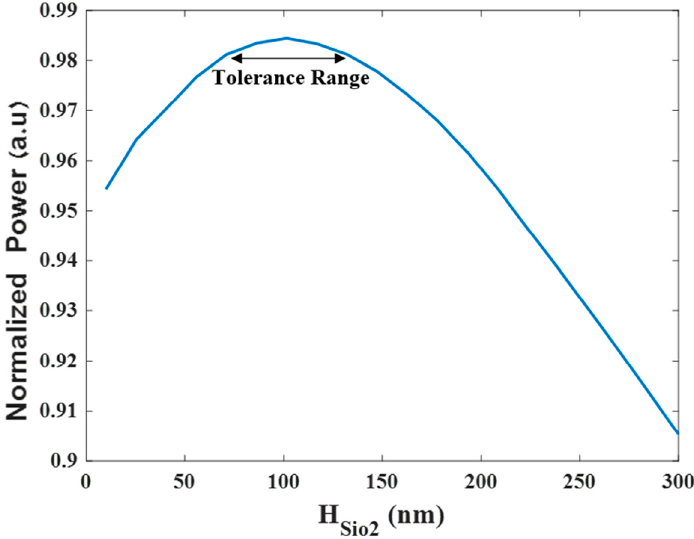
Figure 2. Tolerance analysis and optimizations of H SiO2 .